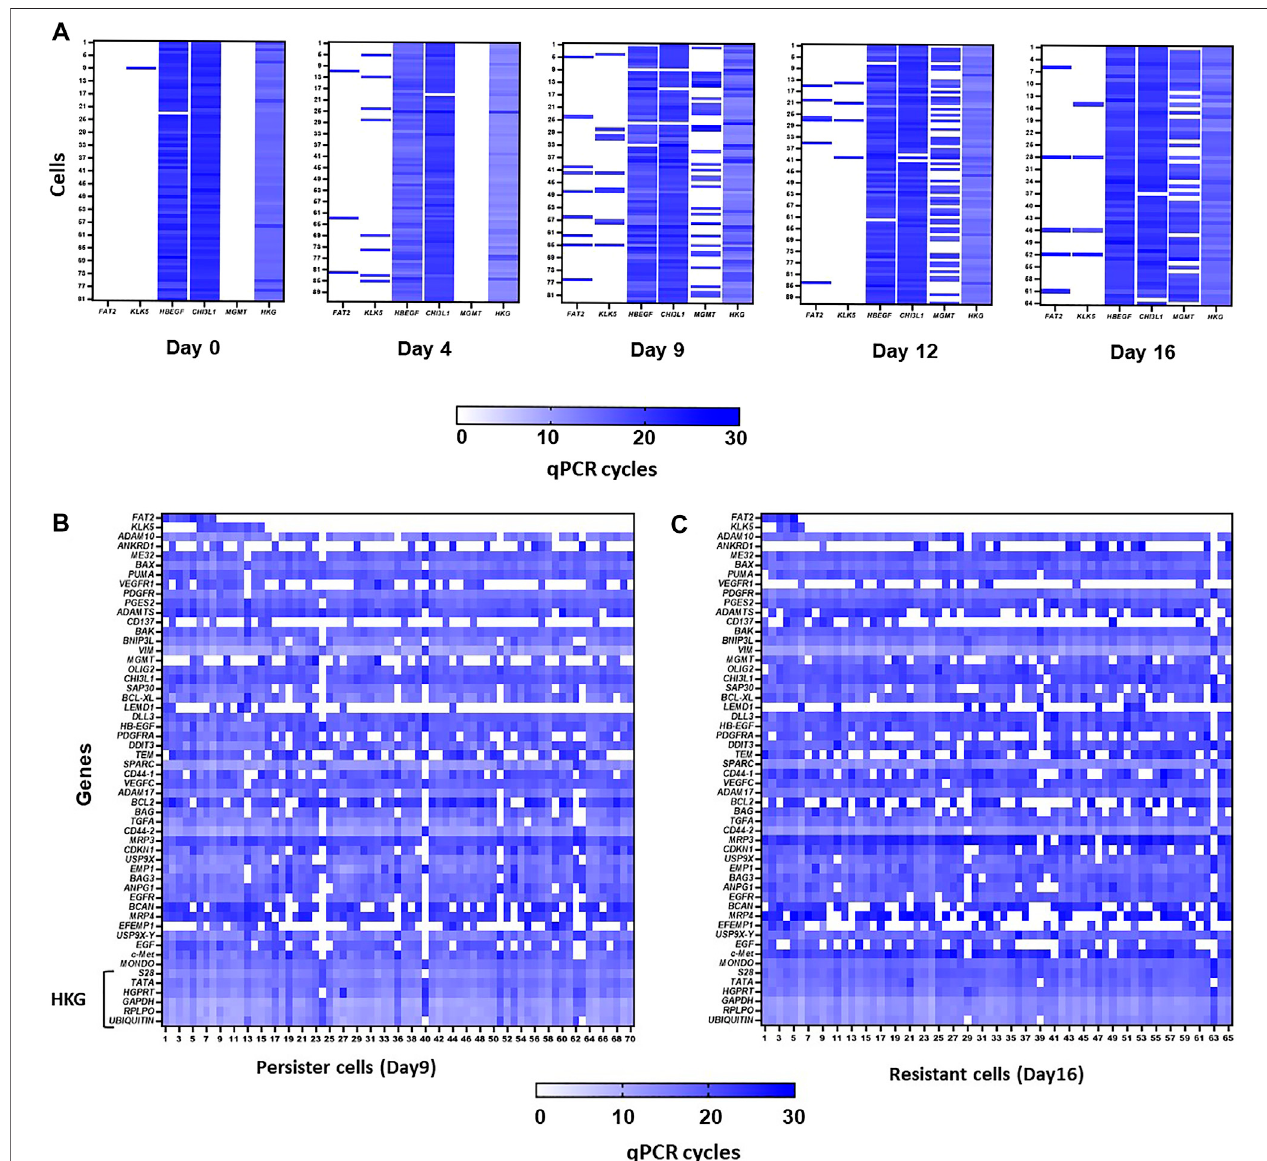
FIGURE 3 | (A) . Heatmaps from single-cellanalysis using C1 Fluidigm technology. Representation of qPCR cycles for FAT2 , KLK5 , CHI3L1 , HB-EGF , and MGMT genes,at days 0, 4,9, 12,and 16post-treatments ofU251 cells with50 µM TMZ.Ct averageofsixhousekeepinggenes isrepresented incolumn HKG. (B,C) Heatmap from single-cell analysis using C1 Fluidigm technology. Representation of qPCR cycles in persister (B) and resistant (C) cells for a panel of genes involved in different pathways. HKG: panel of housekeeping genes.